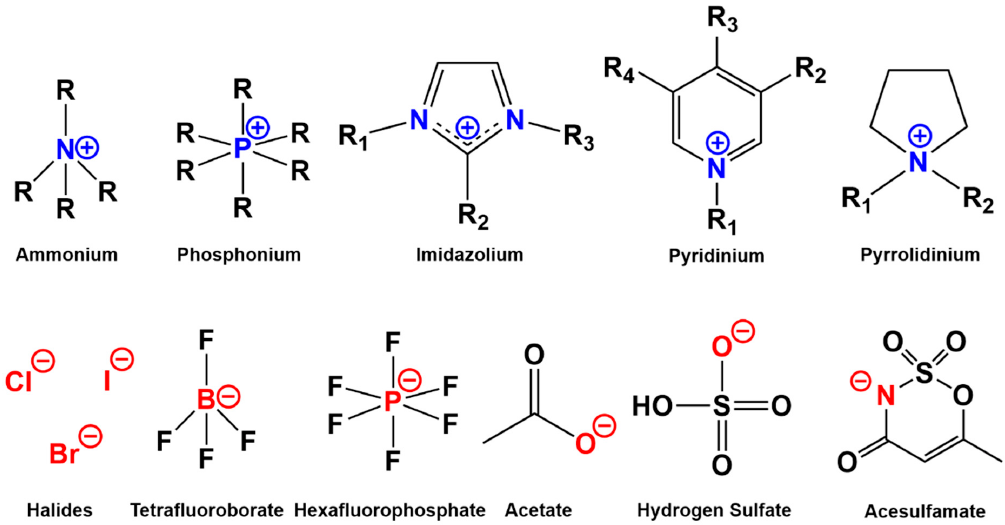
Figure 2. Some of the cations and anions that constitute most of the commonly used ionic liquids for wood and cellulose dissolution and fractionation.